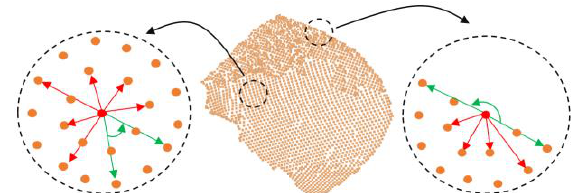
Figure 1. Neighbourhood distribution of one inner point and one edge point